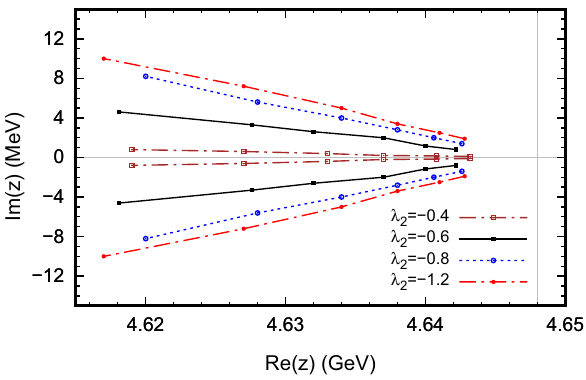
Fig. 2 The trajectory of pole of bound state from the D ∗ s ¯ D s 1 − D s ¯ D s 1 interaction with J PC = 1 −− in the complex-energy plane of z = E R − i Γ/ 2 with variation of the cutoff Λ , 3.2–3.45GeV with a step 0.05 GeV from right to left, and different values of the parameter λ 2 in unit of GeV −